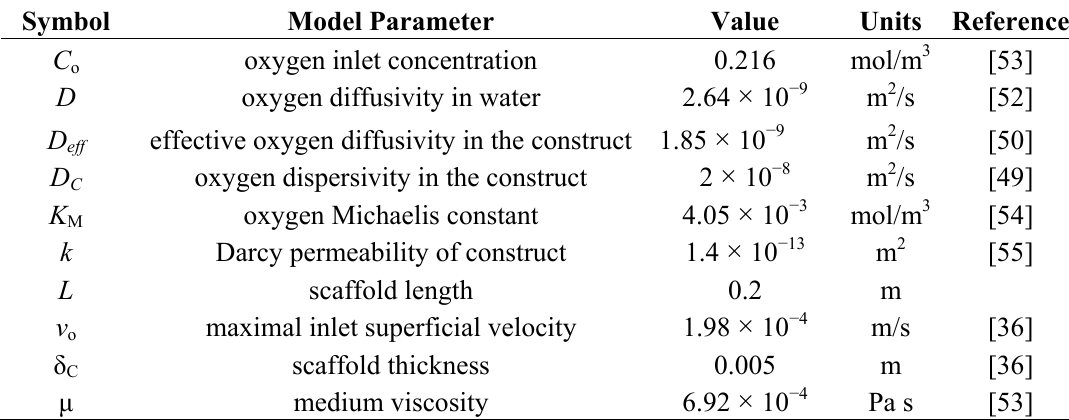
Table 3. Model parameter values used for model predictions, unless otherwise